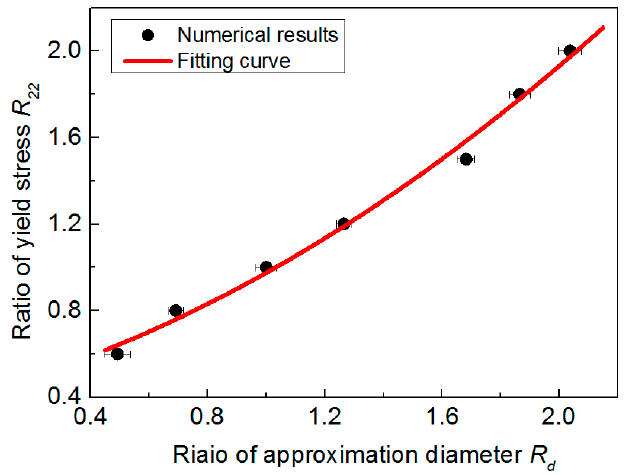
Figure 12. Relationship between R 22 and R d